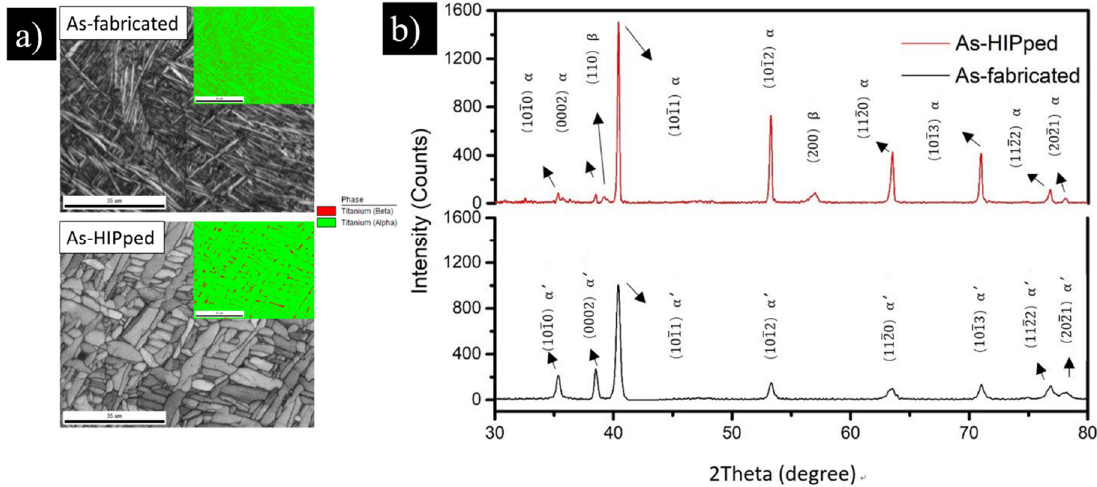
Figure 4. ( a ) EBSD phase map for as‐fabricated and post‐HIP Ti‐64 parts and ( b ) XRD measurement of as‐fabricated and post‐HIP Ti‐6Al‐4V parts. Scale bars = 35µm.